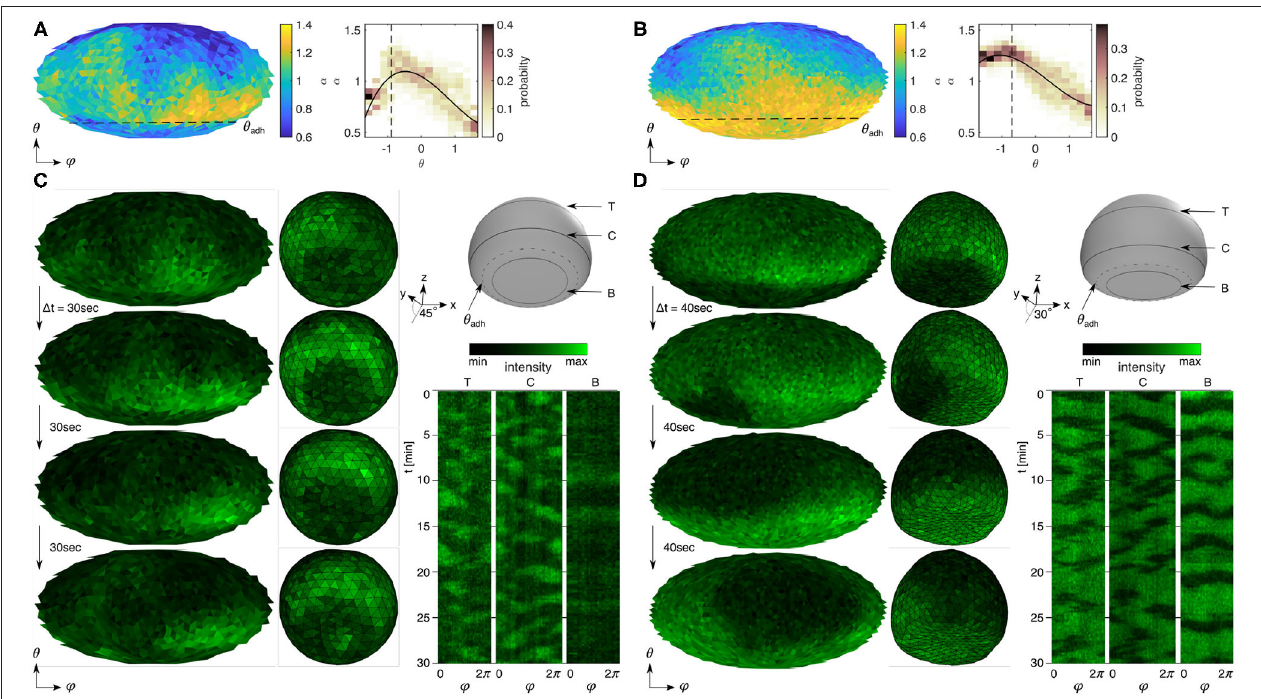
FIGURE 3 | Influence of the contact perimeter on PIP3-enriched domain signaling. (A,B) Detrended fluctuation analysis of the cells that show noisy and oscillatory signaling on the ventral membrane sites (below dashed lines). The left panels show the Mollweide maps of α and the right panels show the respective histograms along the horizontal direction ( θ ) with the weighted polynomial fit (black solid line). See respective fits with confidence intervals in Supplementary Figure 2 . (C,D) Spatiotemporal dynamics of PIP3-enriched domains shown in (A,B) indicating the contact perimeter ( θ adh ) as obstacle (C) and pinning site (D) of spiraling domains. The left panels are four snapshots—2D map and 3D view—of raw PIP3 signaling. The 3D view shows the ventral membrane from the bottom with a view angle of 45 ◦ and 30 ◦ . Three spatiotemporal kymographs of a bottom section [B], a center section [C] and a top section [T], as illustrated in the 3D cell scheme above. The dashed section illustrates the contact perimeter ( θ adh ). The sizes of ventral and entire membrane are (C) A adh A mem 564 µ m 2 =